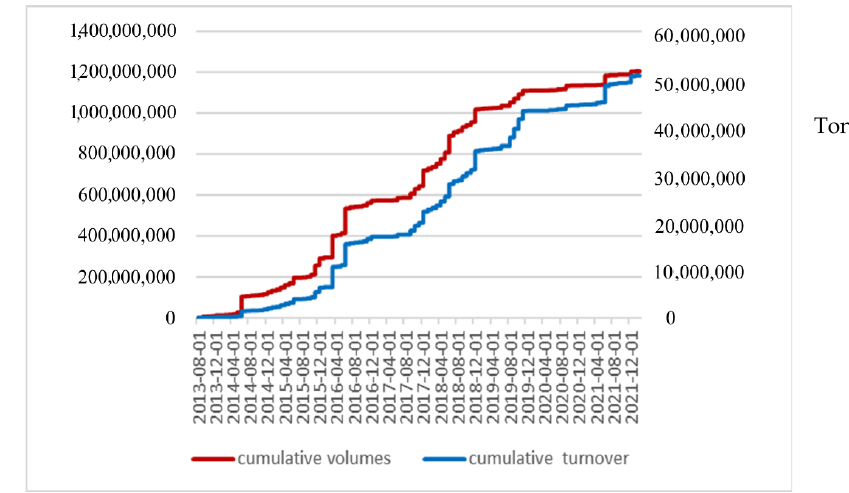
Figure 1. Average trading volume and price of Shenzhen carbon emissions market.